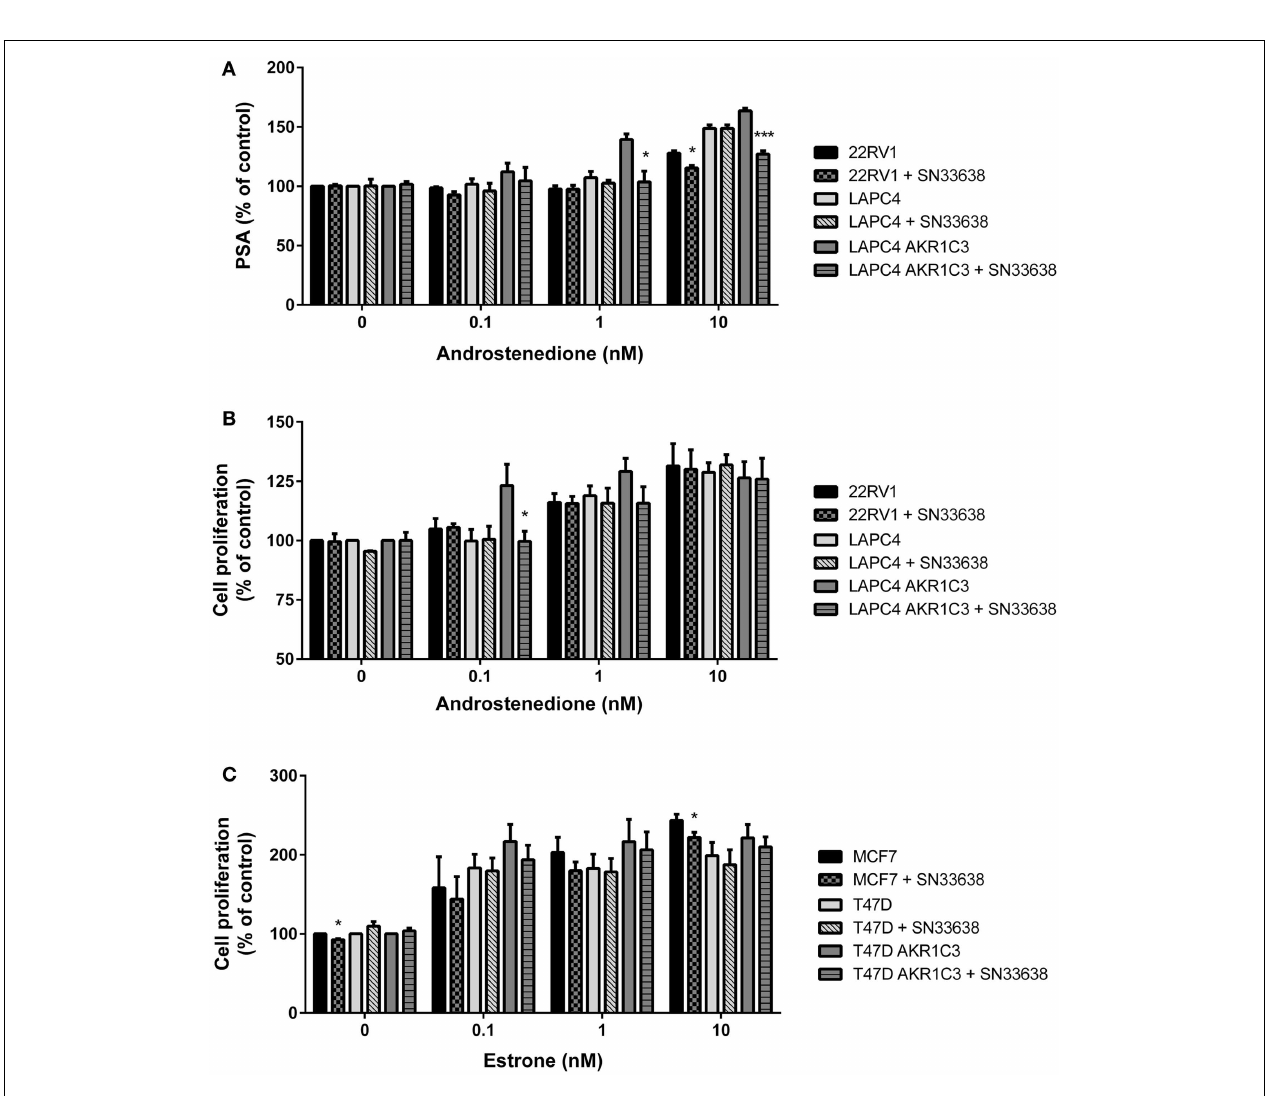
proliferation in (B) CRPC cell lines and (C) breast cancer cell lines 5days after stimulation with androstenedione or estrone and treatment with or without 10 µ M SN33638 ( n = 3–4). Bars represent the mean ± SEM. Significance of differences was evaluated by Student’s t -test. * P < 0.05; *** P < 0.001 vs. no inhibitor